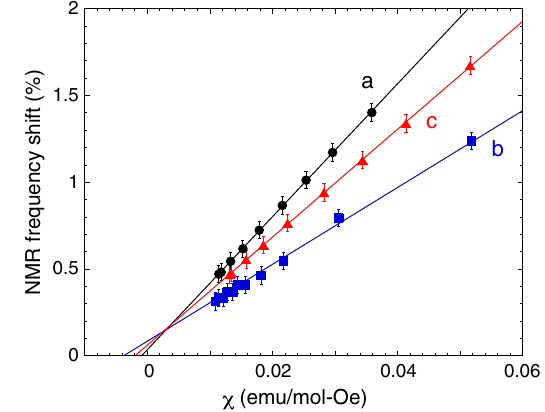
FIG. 10. The NMR frequency shift K ð α Þ vs the bulk magnetic susceptibility χ ð α Þ , with T as the implicit parameter ( α ¼ a , b, or c). The straight lines are the best linear